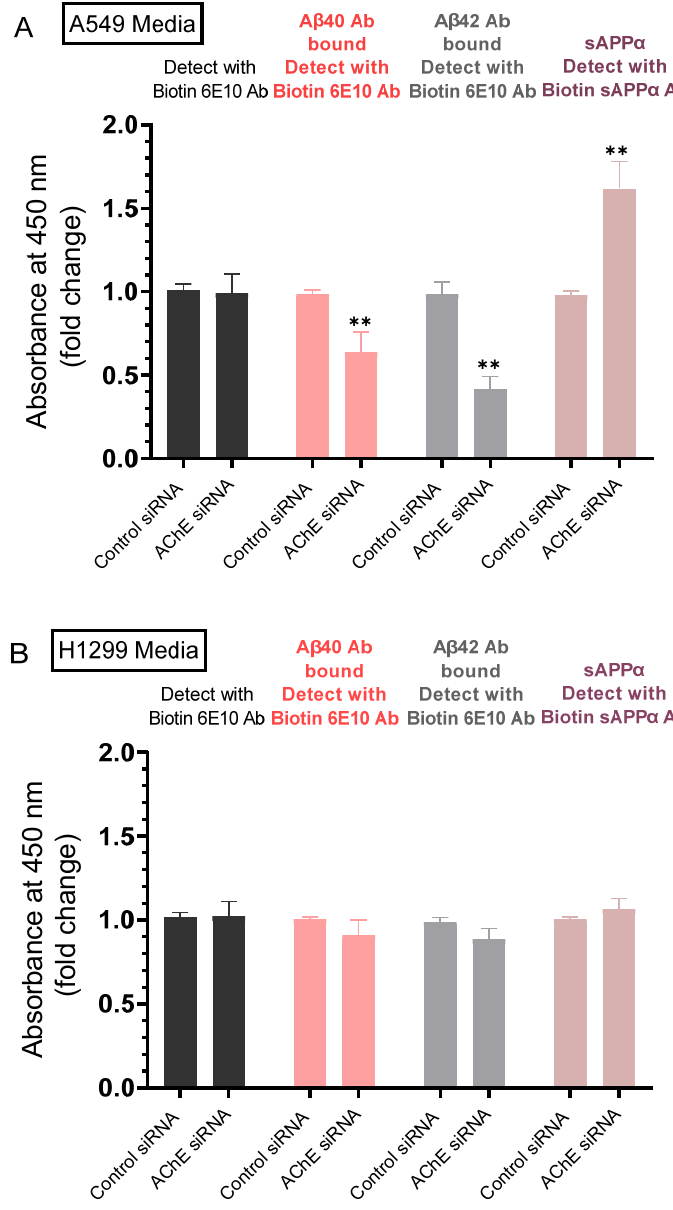
Figure 4. Transfection of A549 cells with AChE siRNA led to lower levels of A β 40 and A β 42 which correlated with higher sAPP α levels in the media, effects that were relatively minimal using H1299 cells. Cells (0.2 × 10 5 ) were grown in 10% FBS-supplemented media for 24 h. The following day, the cell monolayers were incubated in serum-free media for 24 h, then treated for 72 h with the indicated siRNAs as described in the Methods section. The media from A549 ( A ) and H1299 ( B ) cells was then collected and the same amount of protein (3 µ L of 600 µ g/mL total protein) of each sample was used to quantitate A β and sAPP α (Methods) using the indicated antibodies. Data from five independent assays, each carried out in triplicate, were averaged, normalized, and expressed as fold change relative to cells transfected with control siRNA using the GraphPad 9.4.1 software. The graphs summarize the results expressed as means ± SD (n = 5). Asterisks indicate a statistically significant difference from the corresponding control of each cell line. Absence of asterisks indicates no significance, Mann–Whitney test, ** p <